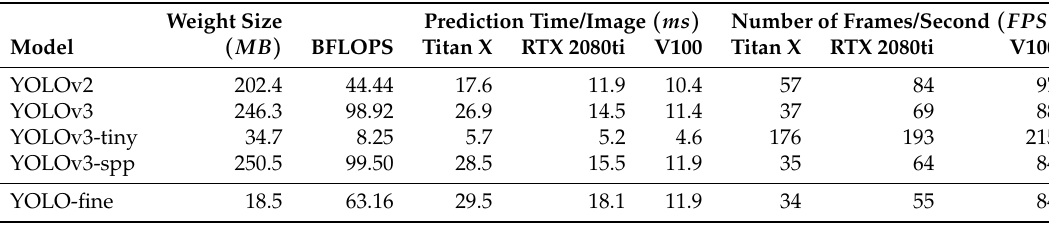
Table 8. Comparison of YOLO-based detection models in terms of storage and computational requirements. Prediction time was tested on three different GPUs.